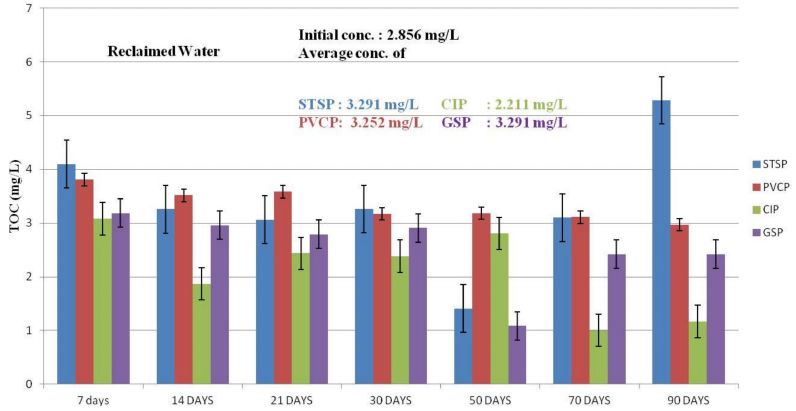
Figure 9. Total organic carbon for RW over time with standard error